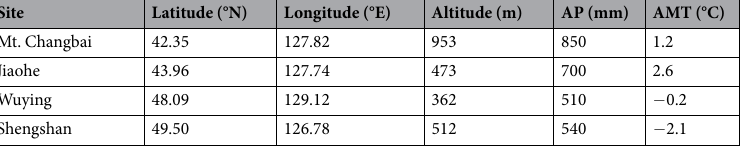
Table 1. General information of four study sites in Northeast China. Abbreviations: AP, annual precipitation; AMT, annual mean